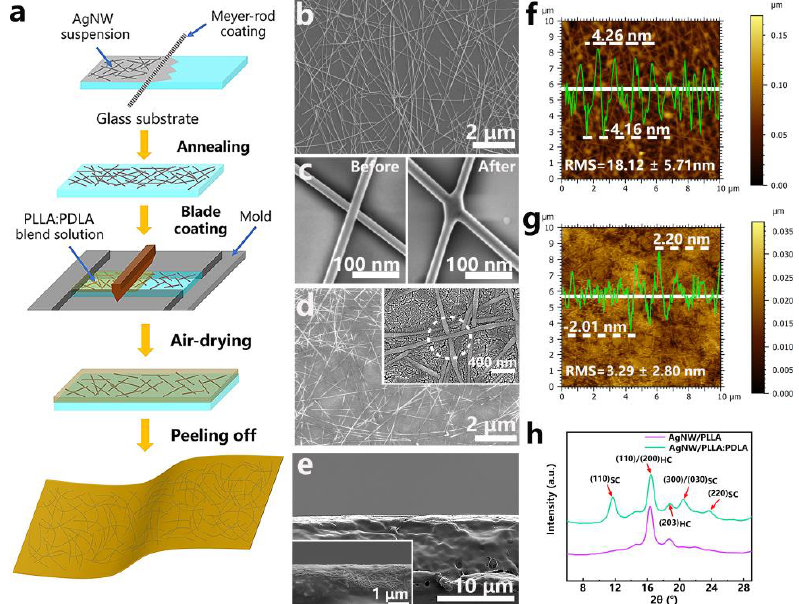
Figure 1. ( a ) Schematic illustration of the fabrication process of the AgNW/PLLA:PDLA film. SEM images of ( b ) the surface of the AgNW/Glass film with a 72 mg/m 2 AgNW area densities, ( c ) the adjacent AgNWs of the AgNW/Glass film before and after annealing treatment, and ( d ) the surface of the AgNW/PLLA:PDLA film with a 72 mg/m 2 AgNW area density. ( e ) Cross-sectional SEM images of the AgNW/PLLA:PDLA film with a 72 mg/m 2 AgNW area density. AFM images (the inserted green curve is the surface height of the marked white line) of ( f ) the AgNW/Glass film and ( g ) the AgNW/PLLA:PDLA film with a 72 mg/m 2 AgNW area density. ( h ) WAXD profiles of the AgNW/PLLA and AgNW/PLLA:PDLA films.